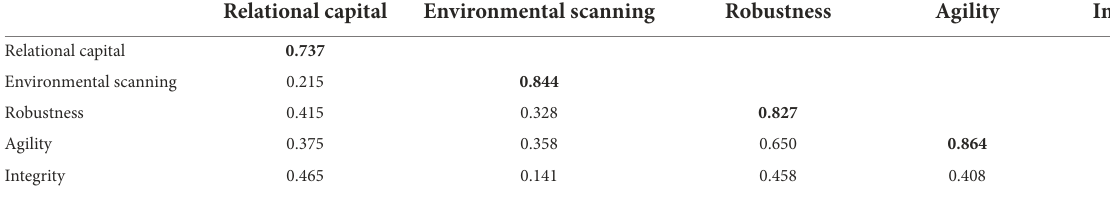
TABLE 4 Fornell-Larcker Criterion (correlation between constructs and the square root of AVE).